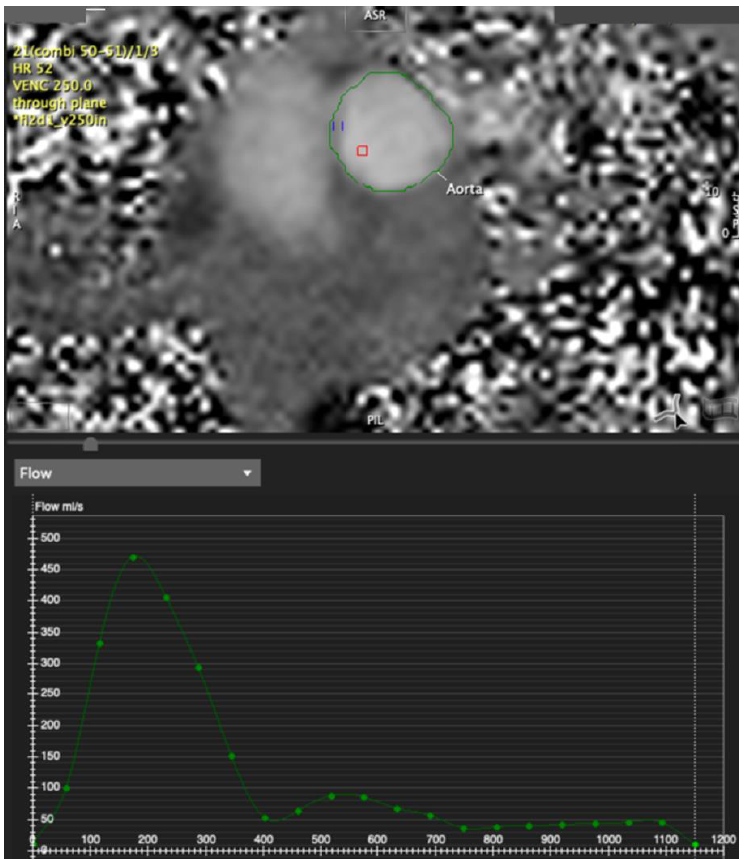
Figure 5. Aortic phase contrast flow imaging; upper panel phase image in the ascending aorta showing a very clean signal with sharp borders allowing ease of tracing along the aortic border. Lower panel: quantitative flow-time curve (processed with Circle Cvi42 software).